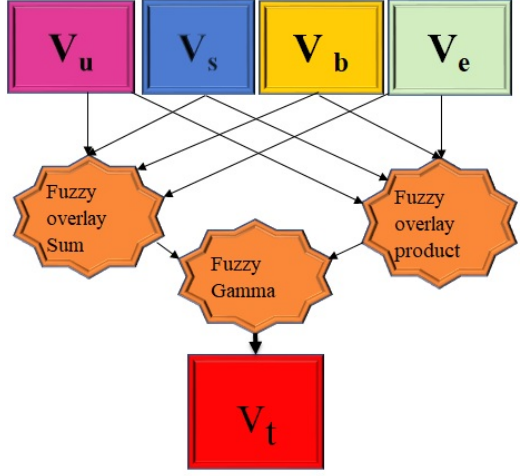
Figure 10. FOG was used to aggregate the four vulnerability indicators (environment, urban, social and building) into a single indicator, called the comprehensive vulnerability indicator.